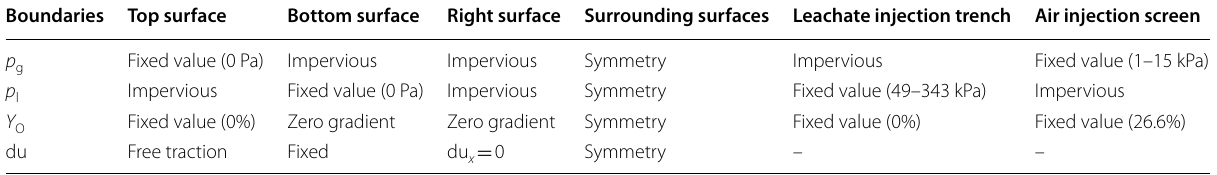
Table 1 Boundary conditions for numerical simulations Boundaries Top surface